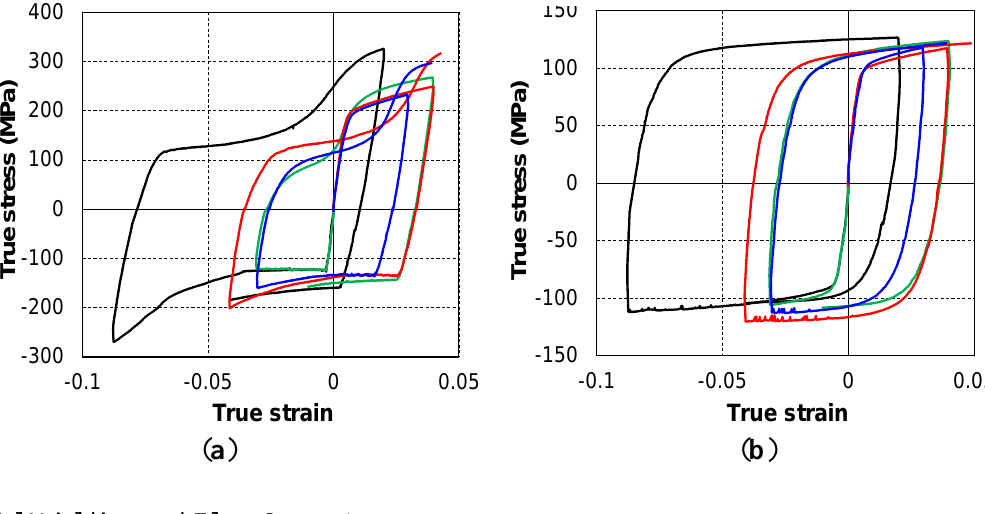
Figure 14. Stress-strain hysteresis loops of cyclic test at: ( a ) room temperature and ( b ) 150